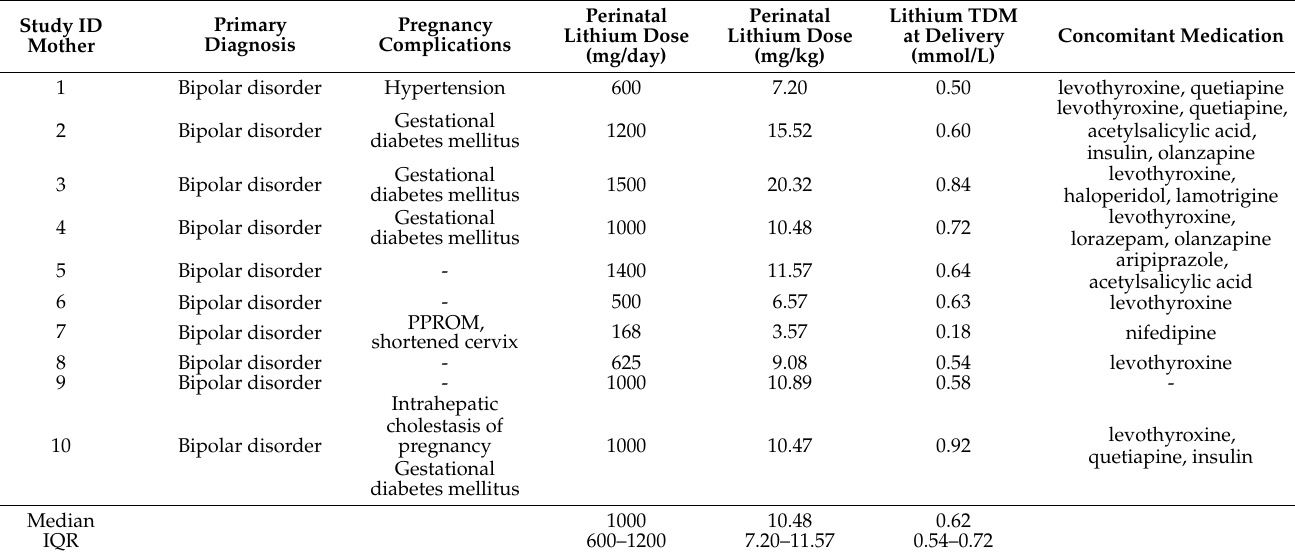
Table 1. Characteristics of the included